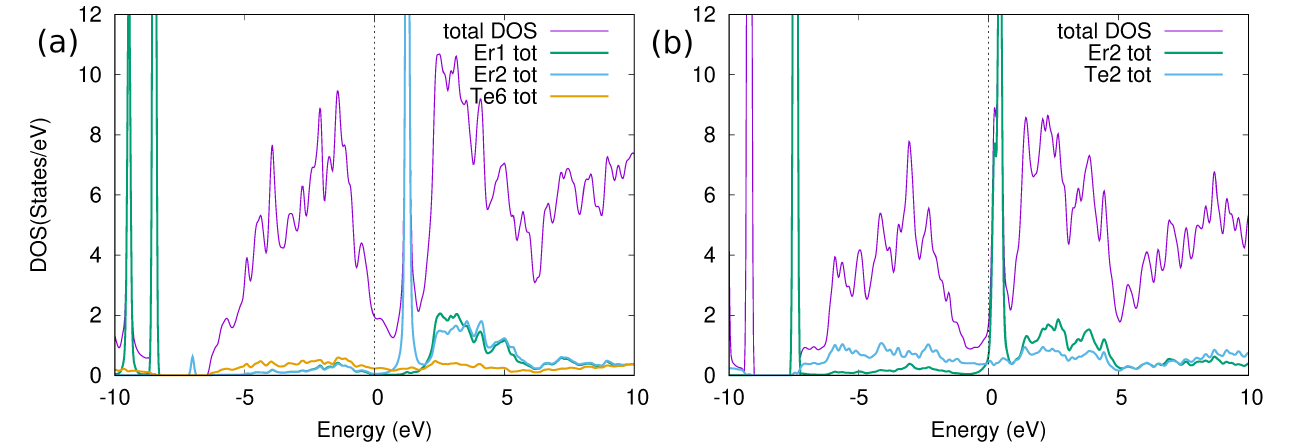
Figure 5. Total and some partial densities of spin-up states for ( a ) stripe antiferromagnetic ErTe 3 and ( b ) intralayer antiferromagnetic ErTe 2 . In the case of stripe AFM ErTe 3 , the partial densities contributed by two nonequivalent Er atoms and one Te atom are shown, along with the total density of states. In intralayer AFM ErTe 2 , the contributions of one Er atom and one Te atom are shown, along with the total density of states. The Fermi energy is set at zero energy and is shown as a vertical dotted